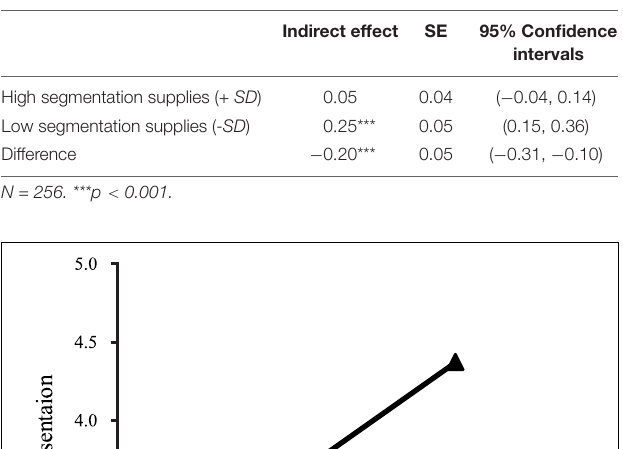
TABLE 4 | Results of moderated mediating effects.